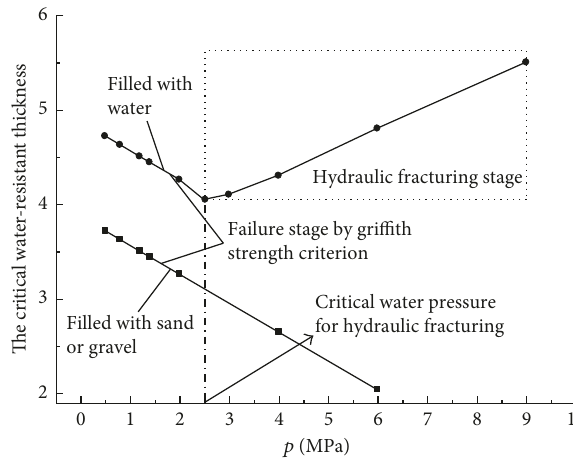
Figure 9: Schematic relationship between the critical thickness and water pressure or filling pressure in the